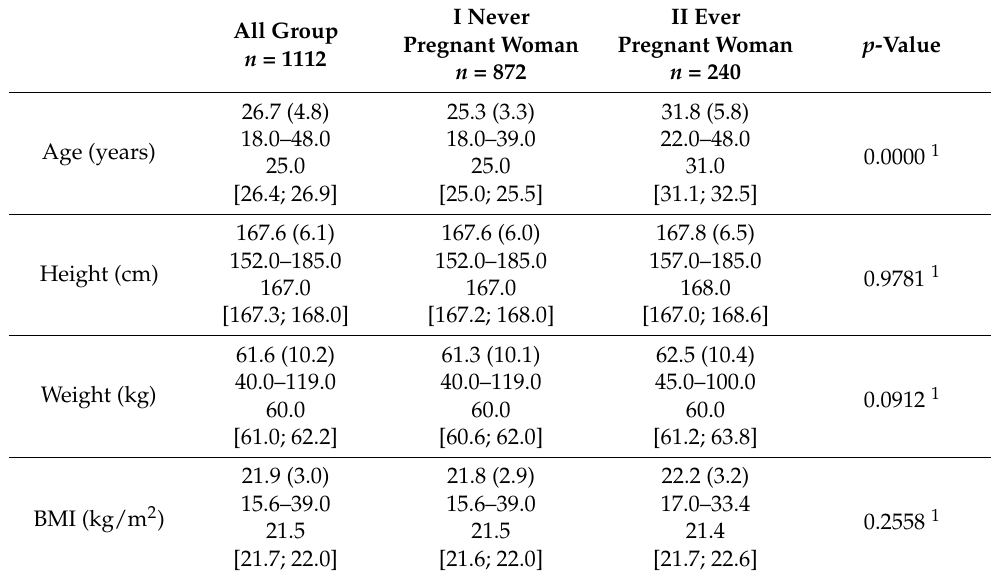
Table 1. Basic characteristics of the studied variables divided into